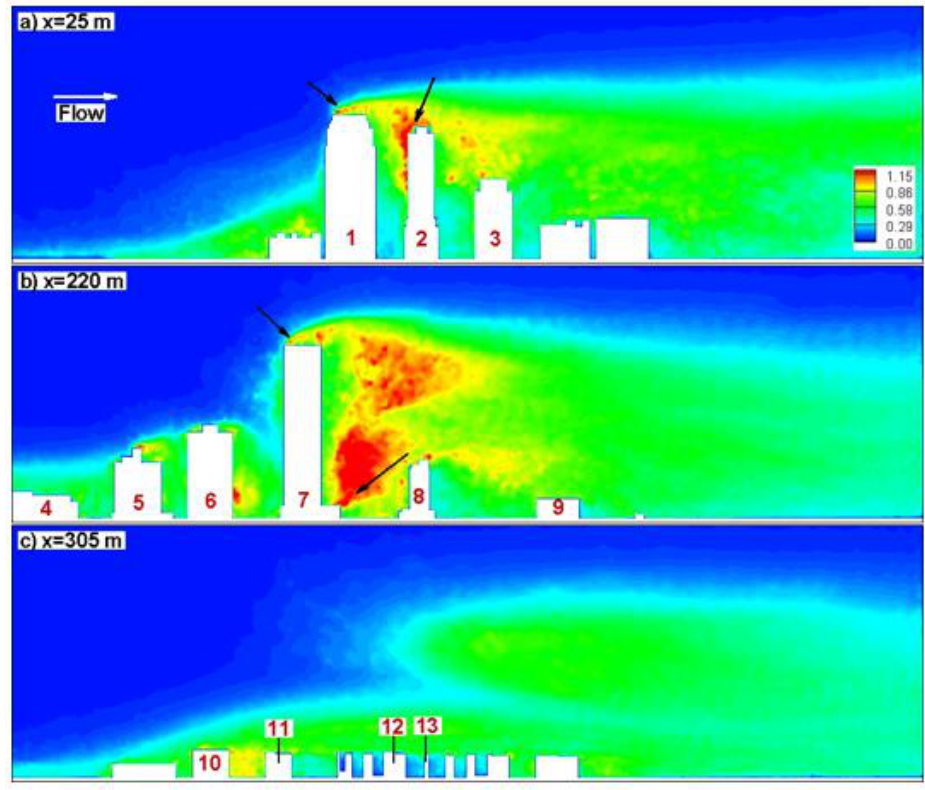
Figure 4. Turbulent intensity contours at ( a ) x = 25 m; ( b ) x = 220 m; ( c ) x = 305 m planes (see the location of planes in Figure 2).